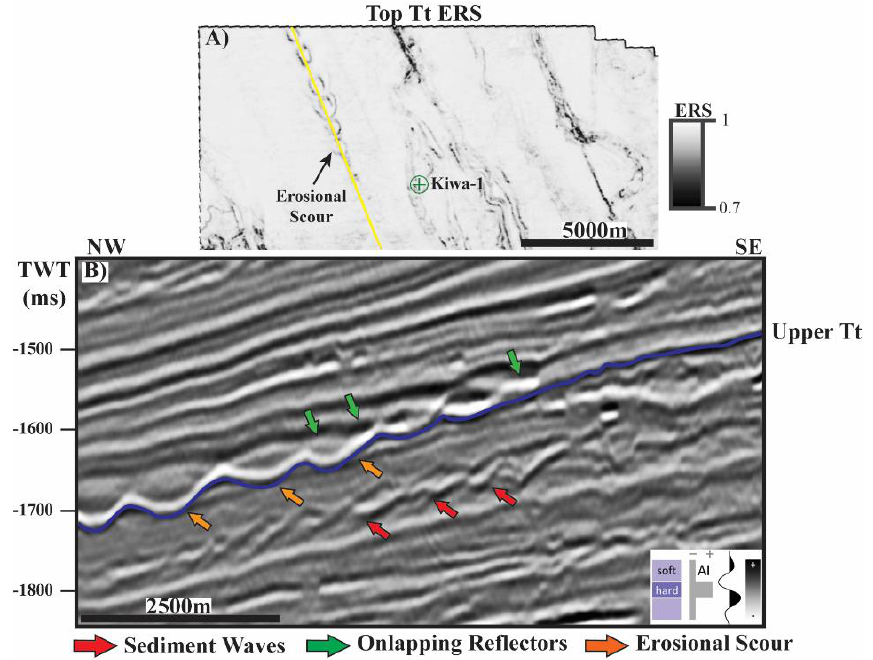
Figure 12. ( A ): Inset of the Top Tt surface draped with the ERS attribute displaying the erosional scours. The yellow line shows the location of B. ( B ): Arbitrary seismic amplitude section showing the undulating, scalloped erosional channel scour. Adjacent planar reflectors are truncated against the anomaly.